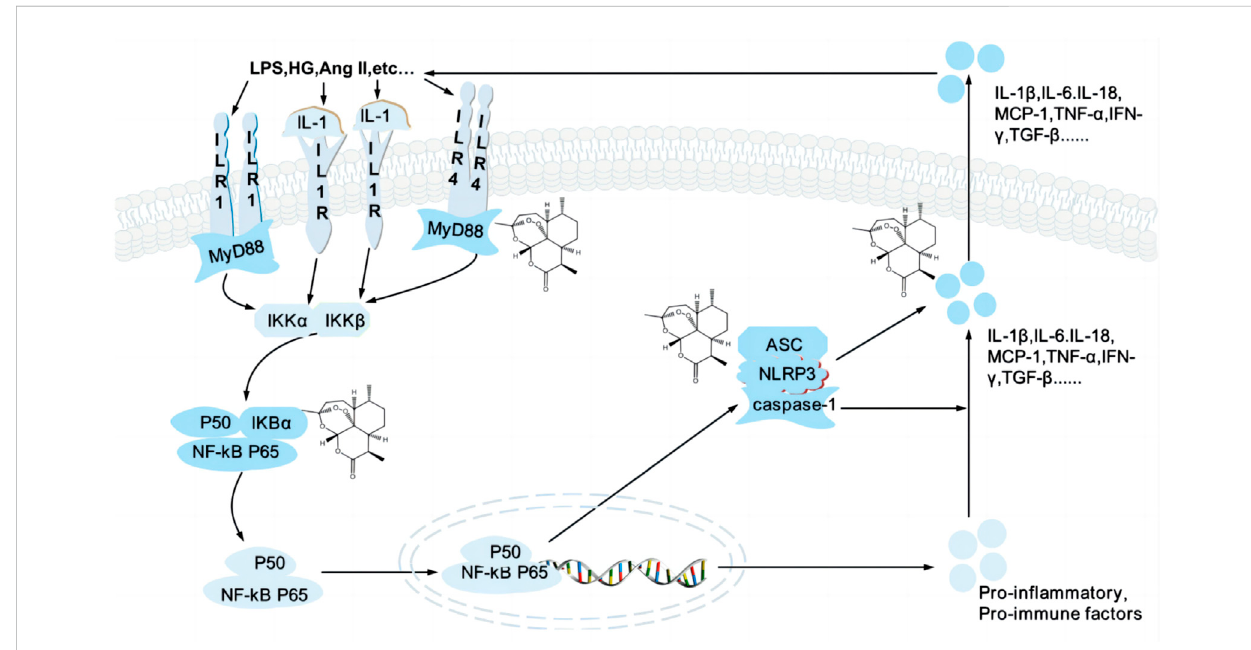
FIGURE 3 Artemisinin and its derivatives target in fl ammation to regulate kidney injury. High glucose, Ang Ⅱ . Trigger activation of TLR/NF- κ B signaling pathway and NLRP3 in fl ammasome, release in fl ammatory cytokines and chemokines and induce in fl ammatory responses, which lead to podocyte injury. Artemisinin and its derivatives can regulate various targets of the signaling pathway (structural formula of artemisinin), inhibit the formation of in fl ammatory factors and reduce the secretion of in fl ammatory factors, reduce the in fl ammatory response, and repair kidney injury. TLR4, Toll-like receptor 4; MyD88, myeloid differentiation factor 88; LPS, lipopolysaccharide; HG, high glucose; Ang II, angiotensin II; TNF- α , tumor necrosis factor alpha; IL-1, interleukin-1; IKK, an inhibitor of kappa B kinase; NF- κ B, Nuclear factor-kappaB; NLRP3, nucleotide leucine-rich polypeptide 3; MCP, monocyte Chemoattractant Protein; IFN- γ , interferon-gamma; TGF- β , transforming growth factor ß